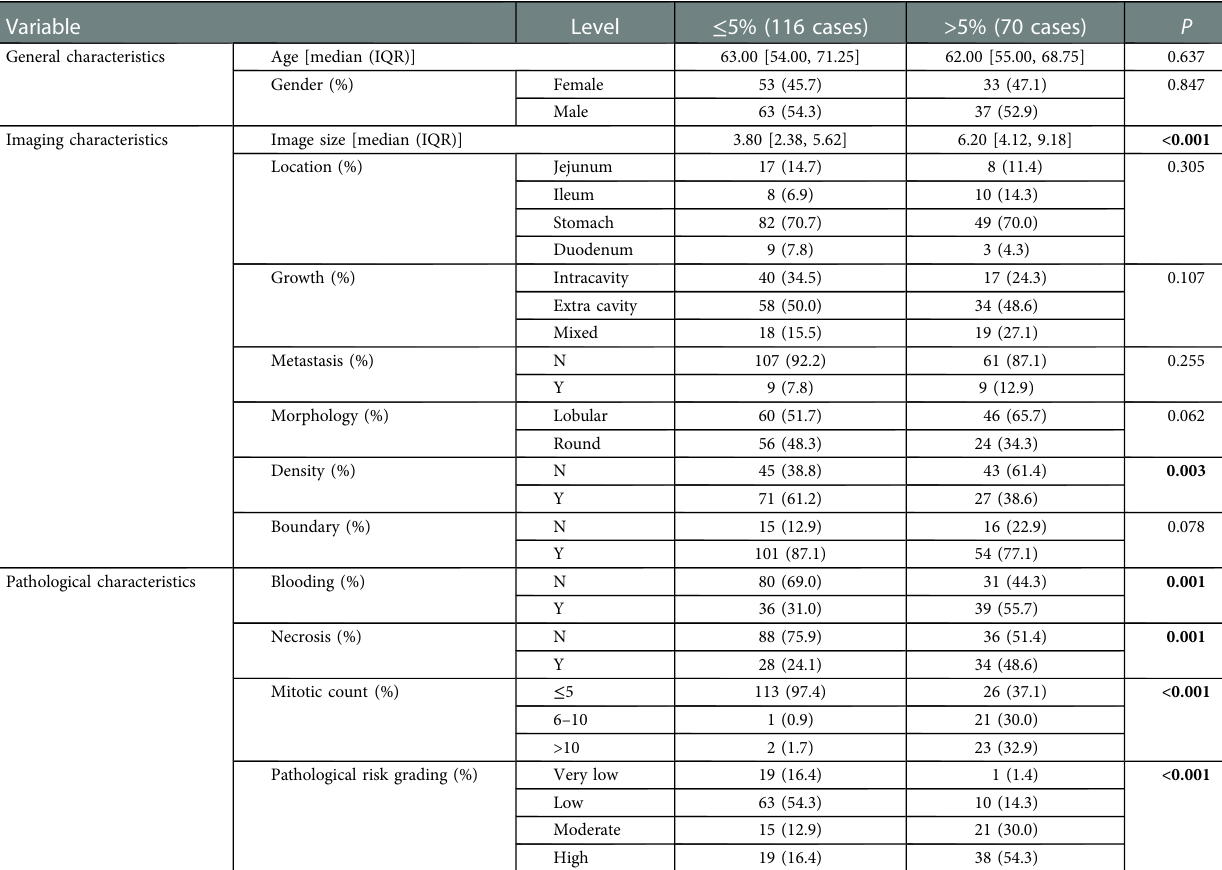
TABLE 2 Comparison of the Ki-67 subgroups.